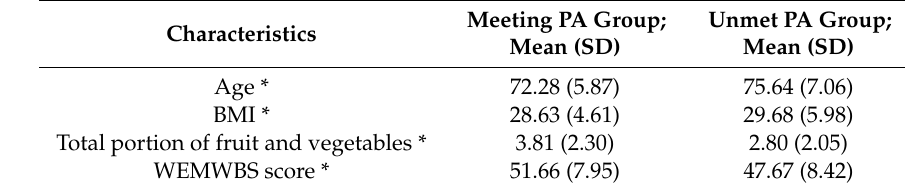
Table 4. Di ff erence of continuous variables among